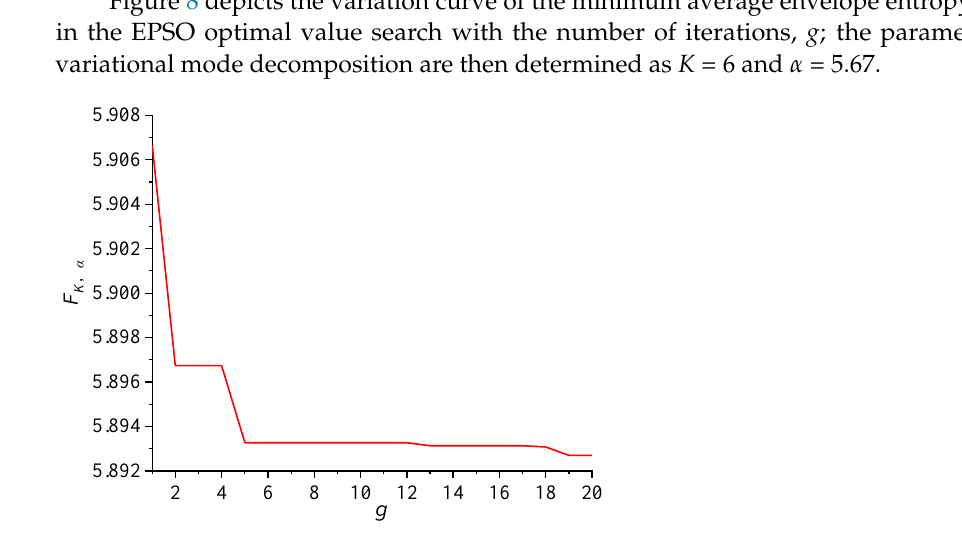
Figure 8. Iterative process of variational mode decomposition parameter optimization.